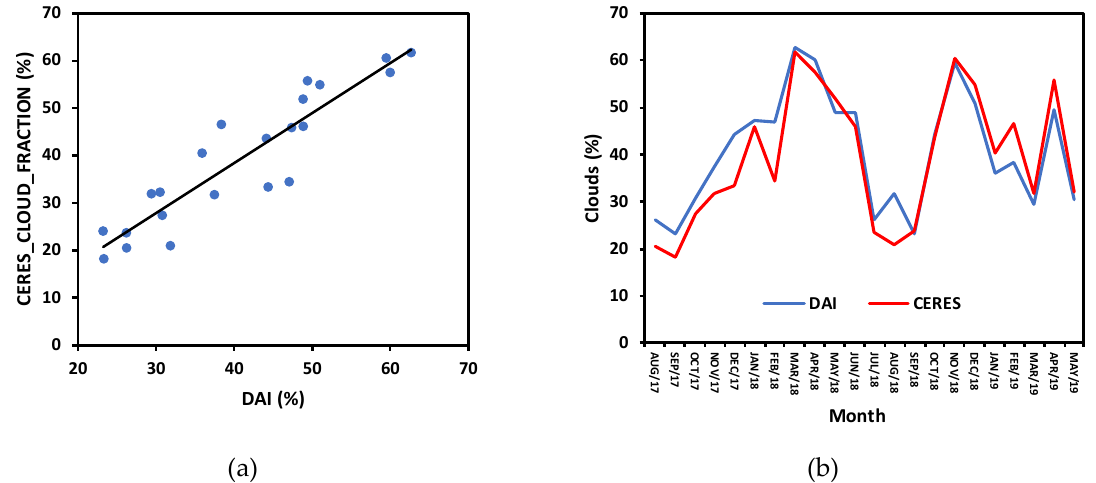
Figure 8. ( a ) Monthly mean cloud cover from Clouds and the Earth’s Radiant Energy System (CERES) versus DNI Attenuation Index (DAI) in Evora, and ( b ) temporal evolution of CERES cloud fraction (red line) and DAI (blue line) in the period between August 2017 and July 2019 (twenty-two months). The black solid line represents the linear